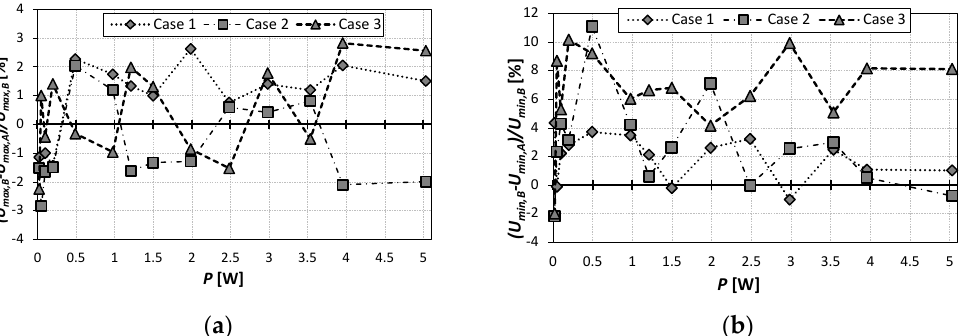
Figure 7. The percentage difference between the maximal ( a ) and minimal ( b ) centerline velocity in cases B and A as a